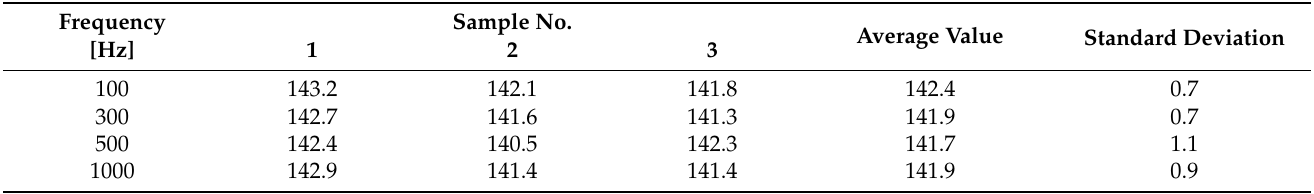
Table 9. Dynamic stiffness (dB re. 1 N/m) for PSMA8 poroelastic layer with PA11 as binder course— laboratory measurements (L).